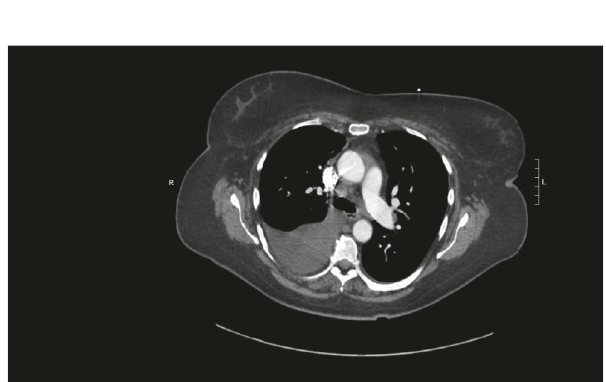
Figure 1: CT of chest showing mediastinal lymphadenopathy with presence of pleural